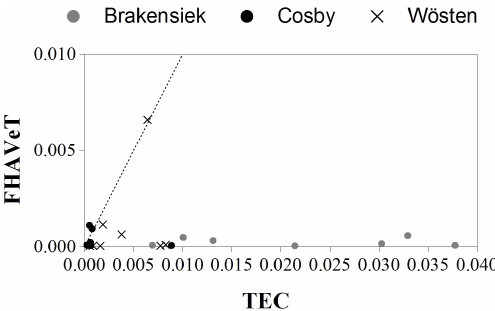
Figure 3. Maximum absolute error in mass balance (in cubic metres of water per unit of soil surface) – comparison between models. The dotted line corresponds to the 1:1 line.